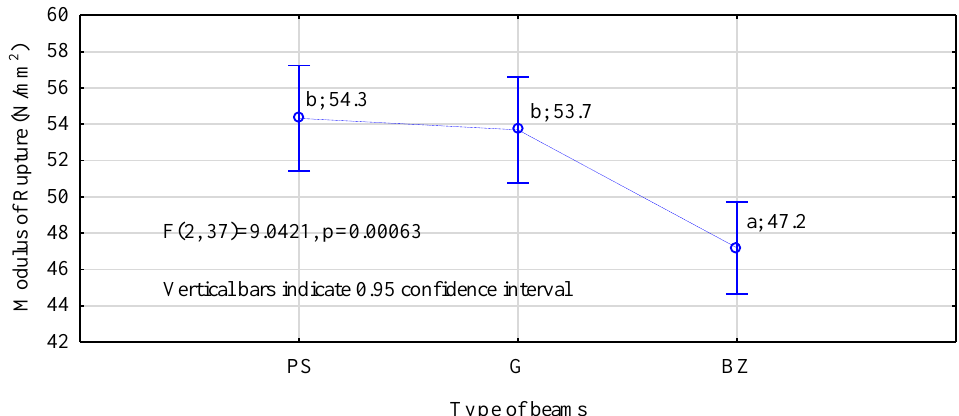
Figure 9. ANOVA for bending strength of rod-reinforced beams (a, b letters mark homogenous groups in the HSD Tukey test).